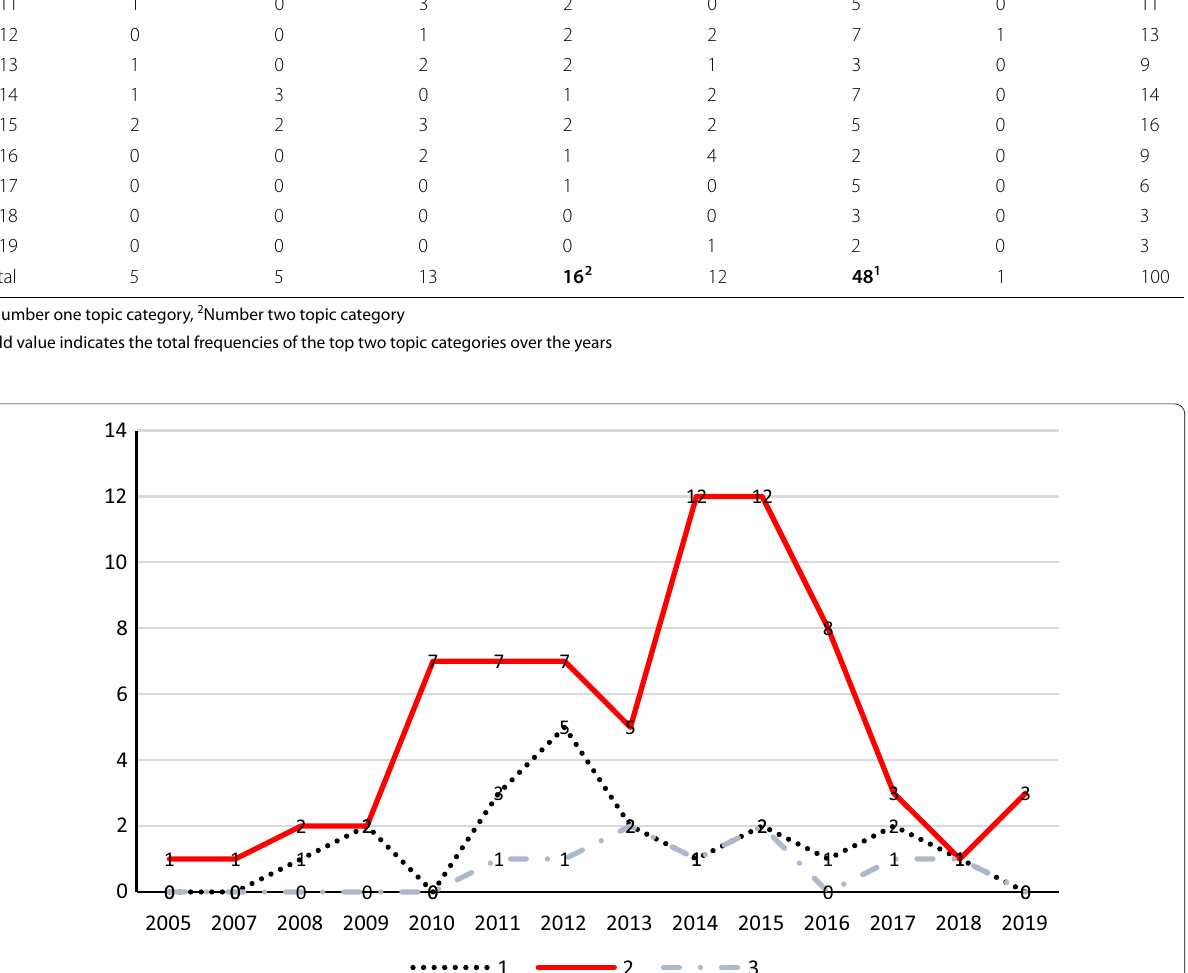
qualitative, 2 quantitative, 3 = = =